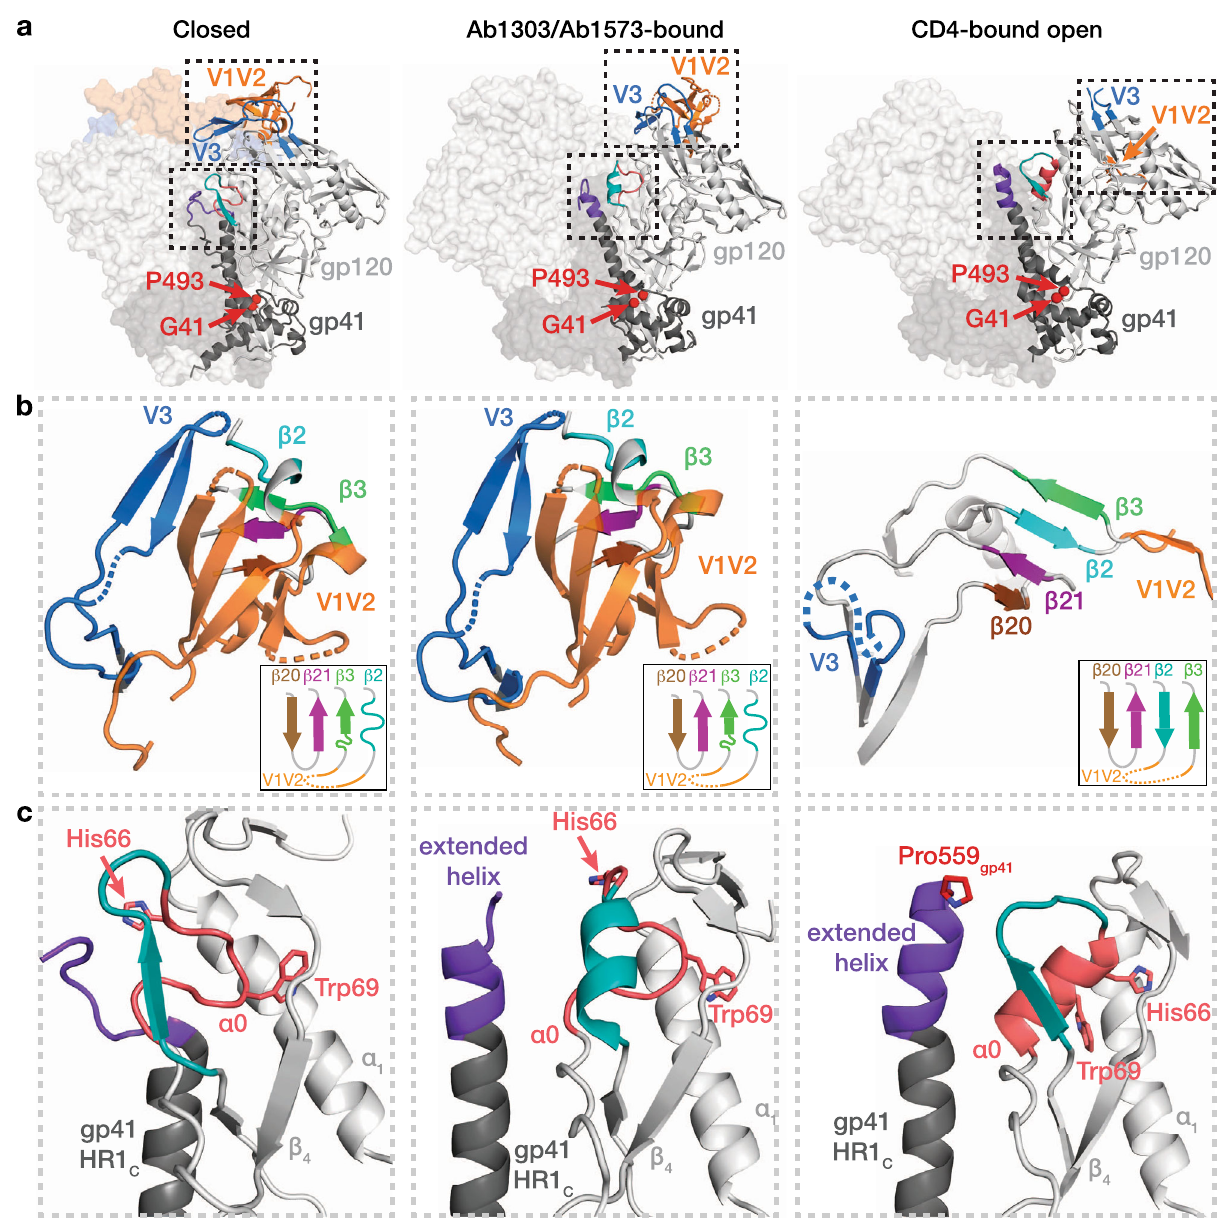
Fig. 6 Structural changes between Env trimer states. a Conformations of gp120/gp41 protomers in closed (left), Ab1303/Ab1573-bound (middle), and CD4-bound (right) states. The gp120 V1V2-V3 regions and gp120 α 0/gp41 HR1C regions are highlighted in dashed boxes. Positions of Gly41 gp120 and Pro493 gp120 are shown as red spheres. b Structural rearrangements of gp120 V1V2 and V3 regions in closed (left), Ab1303/Ab1573-bound (middle), and CD4-bound (right) states. Secondary structures and relative locations of the 3-stranded sheet (left and middle) and rearranged 4-stranded bridging sheet (right) are highlighted, and respective topology models are shown in insets. Dotted lines represent disordered regions. c Comparison of gp120 α 0 and neighboring region in closed (left), Ab1303/Ab1573-bound (middle), and CD4-bound (right) structures. Residues Asp57 gp120 - Glu62 gp120 are teal, α 0 residues (Lys65 gp120 - Ala73 gp120 ) are salmon, with the His66 gp120 and Trp69 gp120 side chains shown. The N-terminal segment of gp41 HR1 C is dark